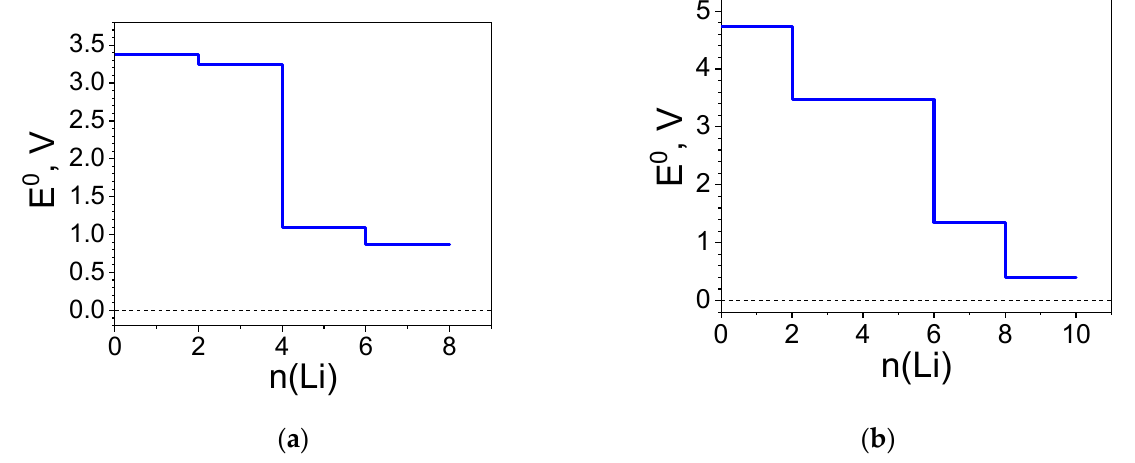
Figure 6. Redox potential profile (E 0 vs. Li + /Li 0 ) of: ( a ) Ni(II)(L1) 2 and ( b ) Ni(IV)(L1) 2 upon lithiation.